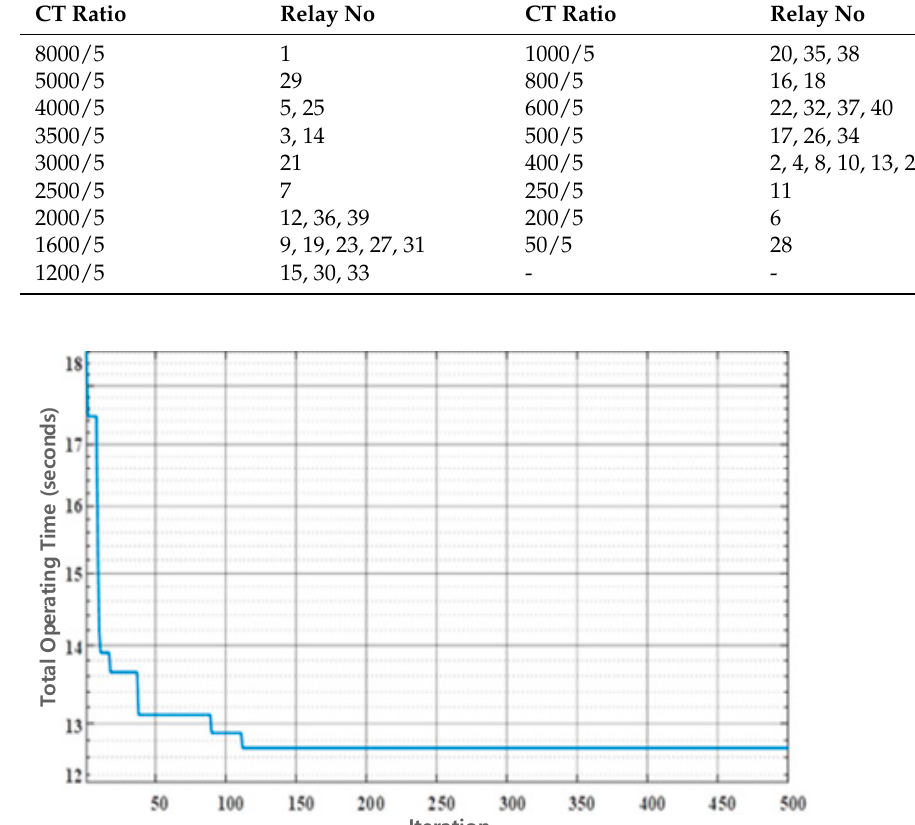
Figure 12. Convergence characteristics of HHO for a 14-bus system.